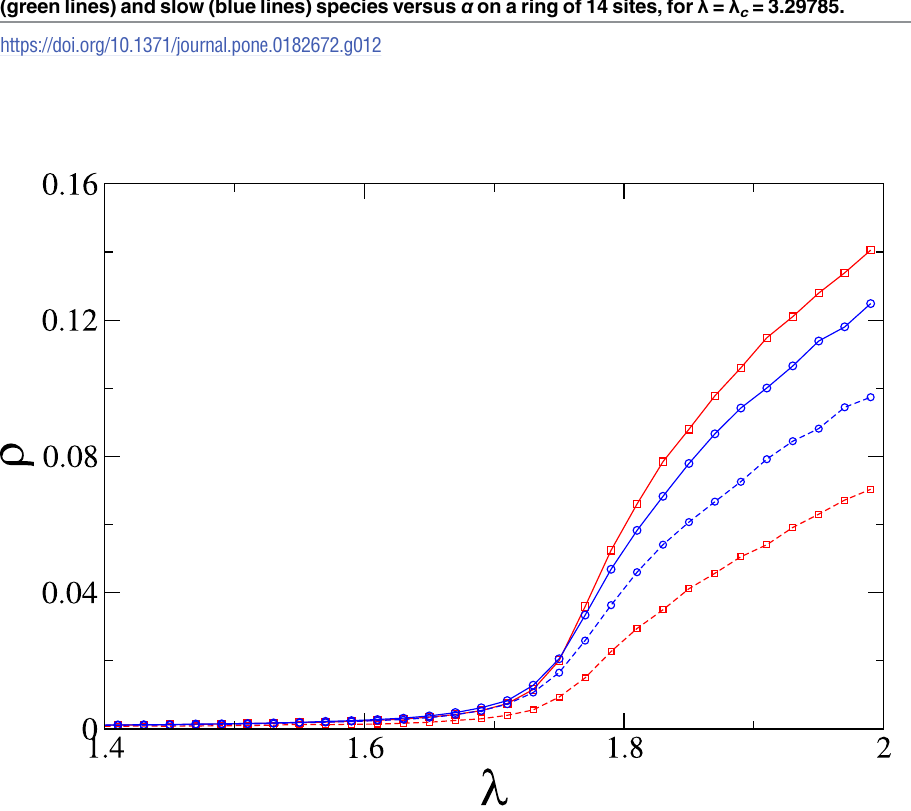
Fig 13. (Color online) Square lattice: Quasistationary population densities ρ A (solid lines) and ρ B (dashed lines) versus reproduction rate λ , for α = 0.1 (red) and α = 0.5 (blue). Linearsystem size: L = 80.